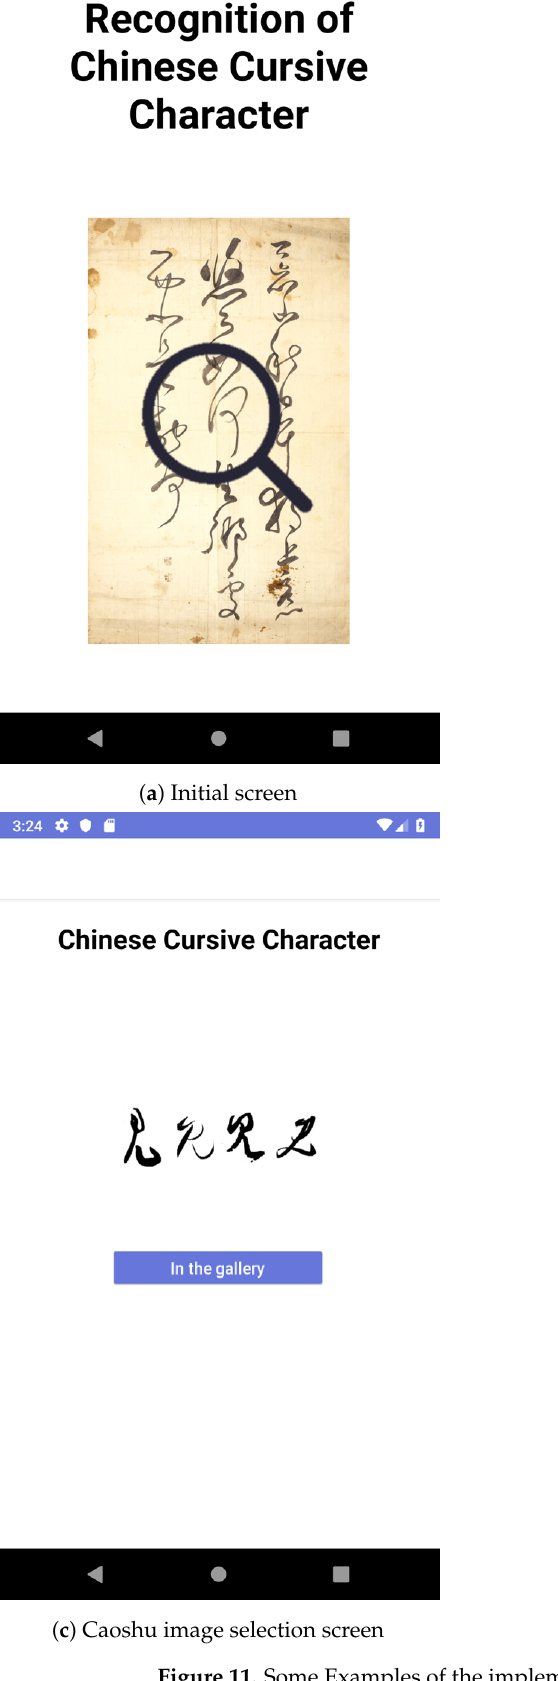
Figure 11. Some Examples of the implemented Caoshu recognition